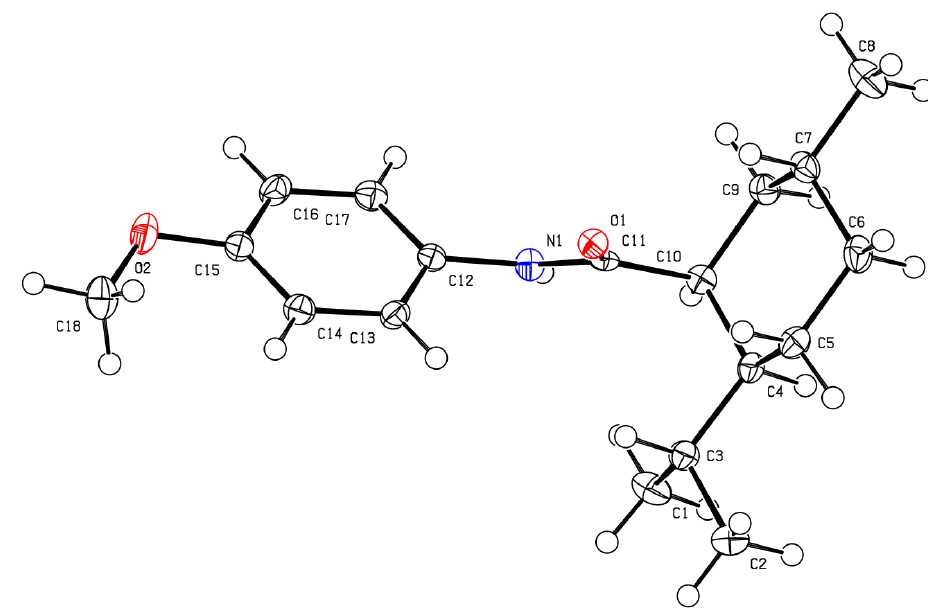
Figure 2. Crystal structure for (1 S ,2 S ,5 R )-diastereomer of AR-15512, 4 . 2.1.2. HPLC Method for the analysis of AR-15512 and Its Diastereoisomer 4 ( neo -AR- 15512)